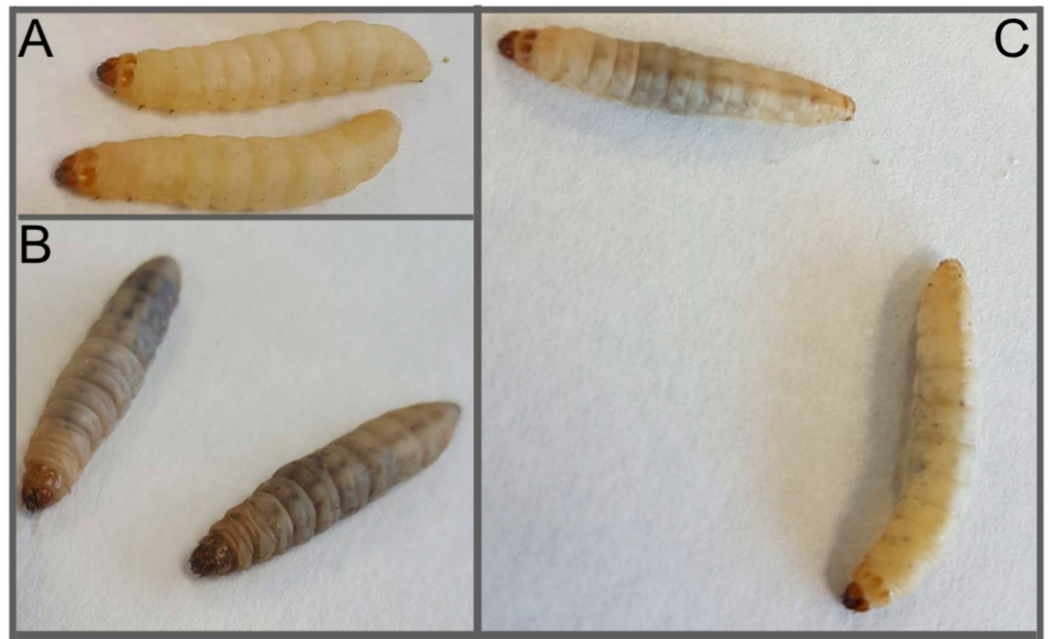
Figure 4. Images of G. mellonella larvae infected with Candida albicans (5 × 10 5 /larva) 24 h post-infection. ( A ) Control larvae administrated PBS (40 µ L), ( B ) larvae administrated C. albicans 24 h post-infection, ( C ) larvae administrated C. albicans and amphotericin B (1 mg/kg 2 h post C. albicans infection) 24 h